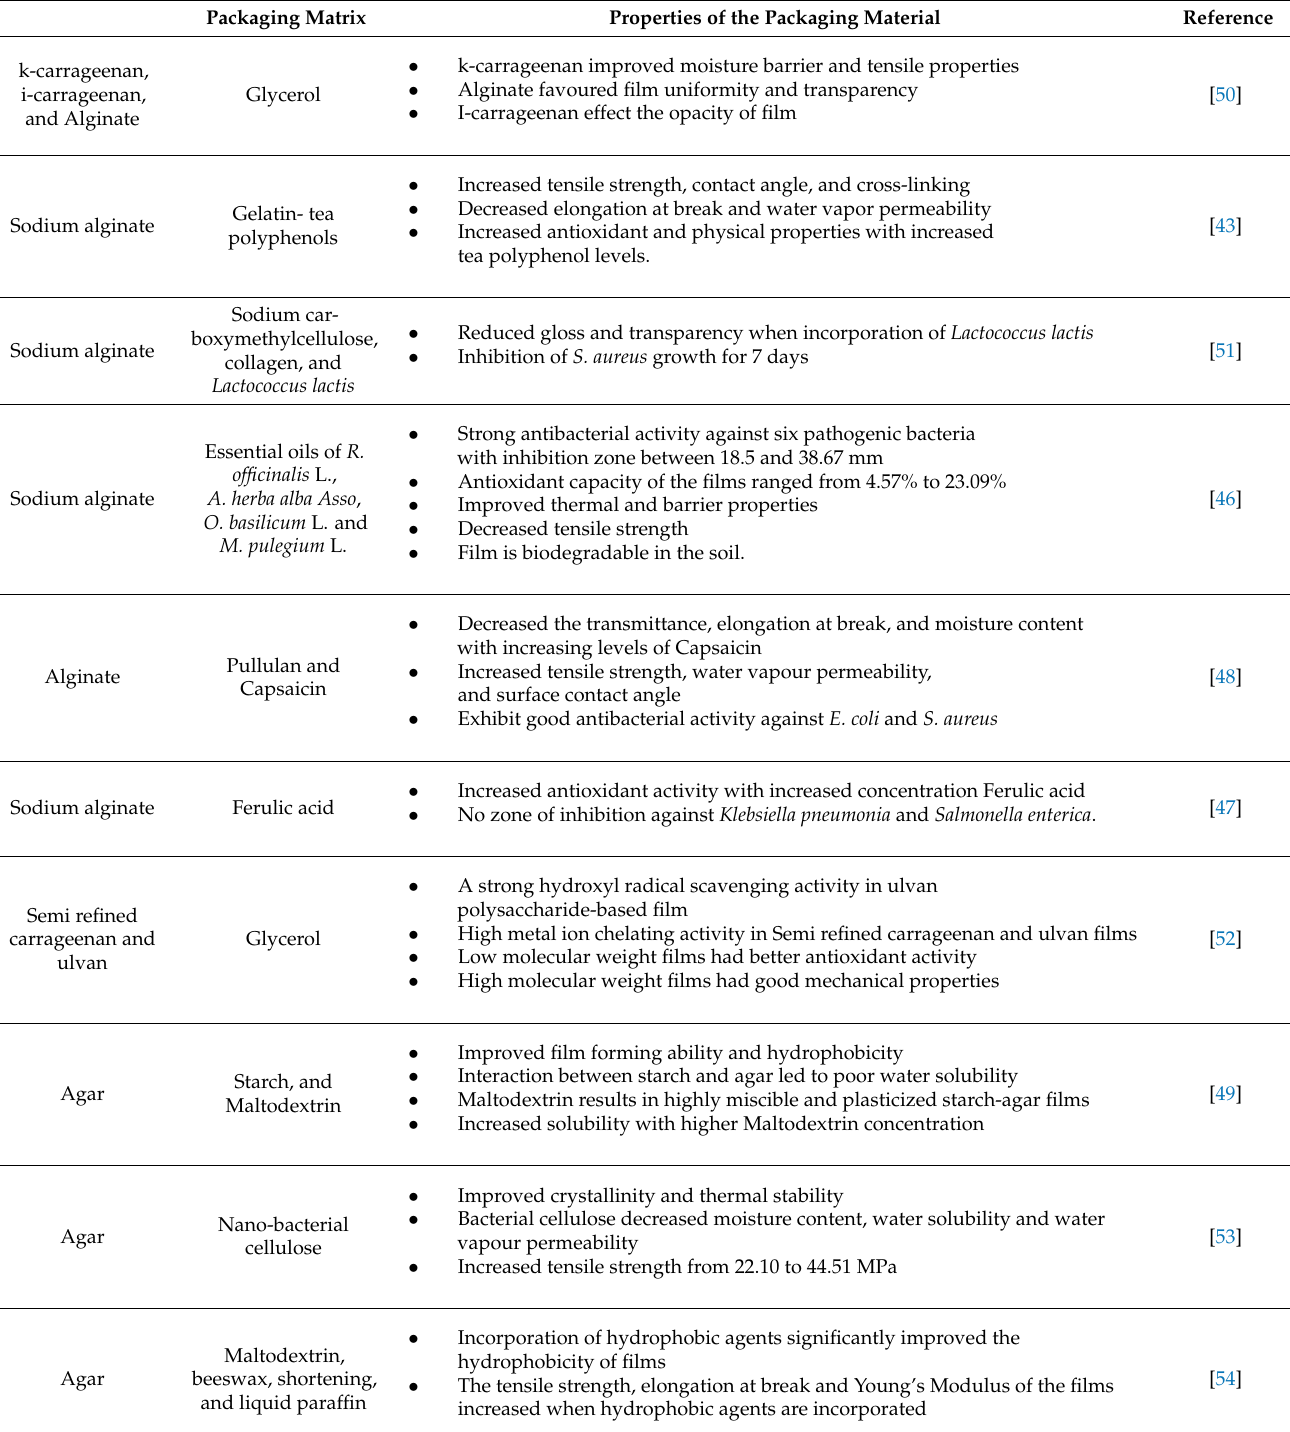
Table 3. Instances of seaweed polysaccharides in edible